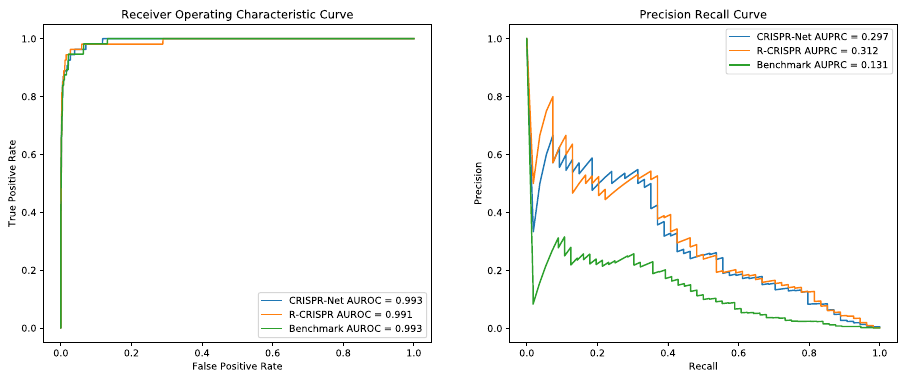
Figure 5. Comparison of CRISPR-Net and R-CRISPR on Dataset GUIDE_II.